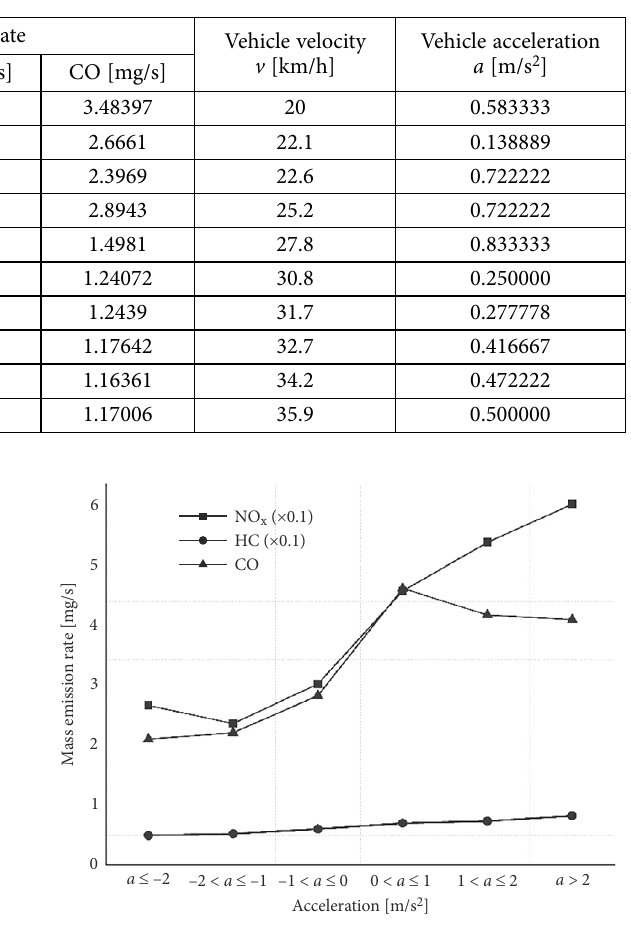
Figure 4. Changes in NO x , HC, and CO mass emission rates with